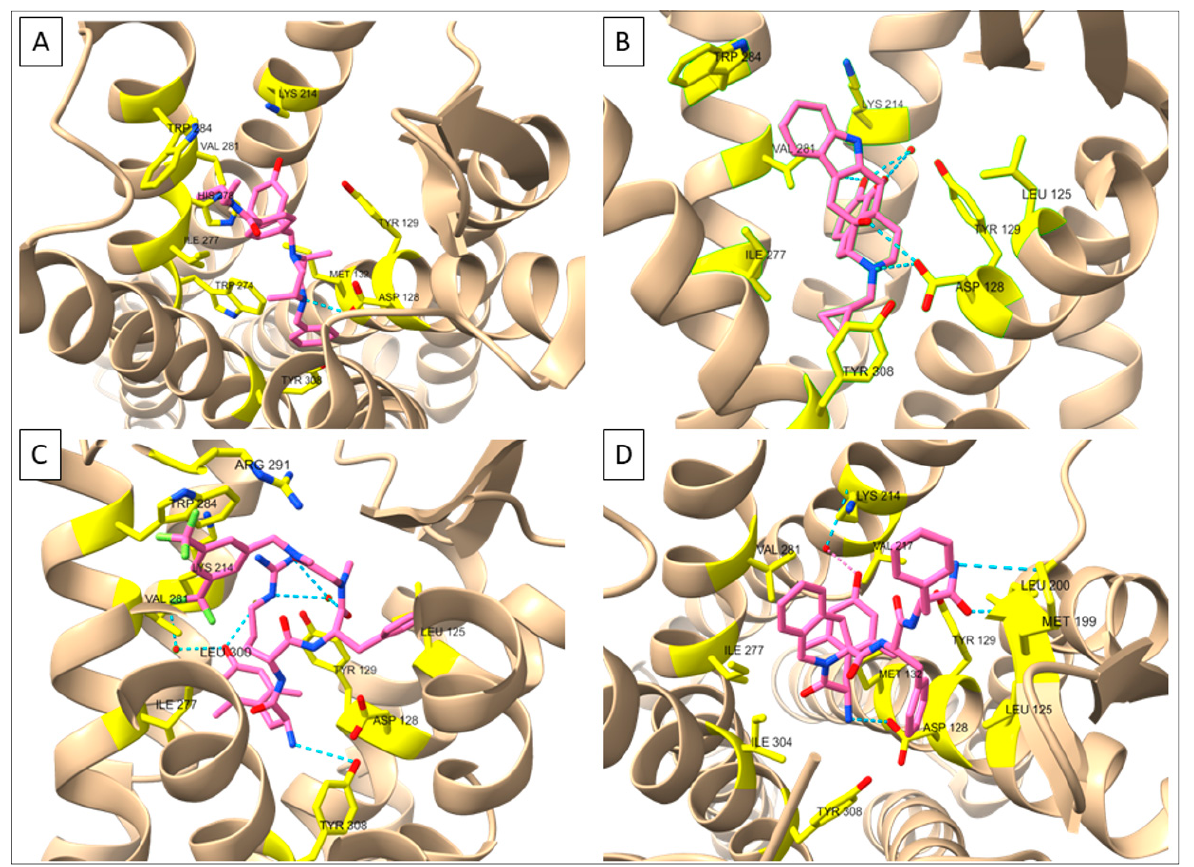
Figure 2. Receptor ‐ ligand interactions at δ OR deduced by X ‐ ray crystallography. ( A ) δ OR ‐ DPI287 Figure 2. Receptor-ligand interactions at δ OR deduced by X-ray crystallography. ( A ) δ OR-DPI287 (PDB: 6PT3) ( B ) δ OR ‐ NTI (PDB: 4N6H ( C ) δ OR ‐ KGCHM07 (PDB: 6PT2) ( D ) δ OR ‐ DIPP ‐ NH2 (PDB: (PDB: 6PT3) ( B ) δ OR-NTI (PDB: 4N6H ( C ) δ OR-KGCHM07 (PDB: 6PT2) ( D ) δ OR-DIPP-NH2 (PDB: 4RWD). Figures made in ChimeraX 1.1. 4RWD). Figures made in ChimeraX